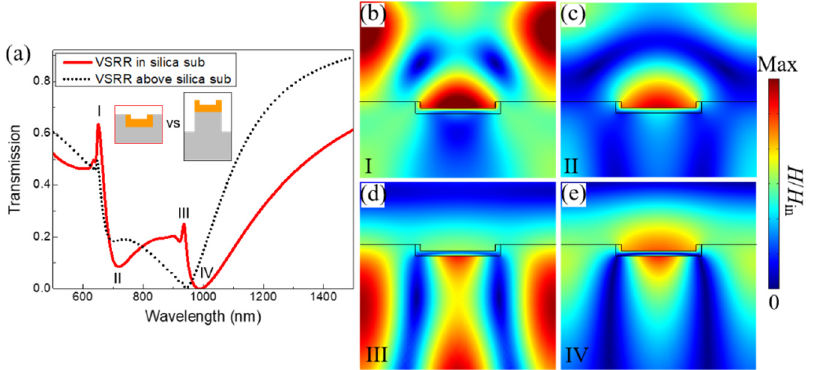
Figure 2. ( a ) The calculated transmission of Au VSRR array embedded in the silica substrate and Au VSRR array suspended by silica pillars. The inset schematically shows the magnified view of the two metamaterials. ( b – e ) Normalized magnetic field ( H / H in ) distributions of Au VSRR array embedded in the silica substrate from the front view at the corresponding transmission resonances of I, II, III and IV, respectively. The structural sizes of the Au VSRR array embedded in a silica substrate: t x = t z = 20 nm, l x = 290 nm, l z = 40 nm, and P = 650 nm, respectively.